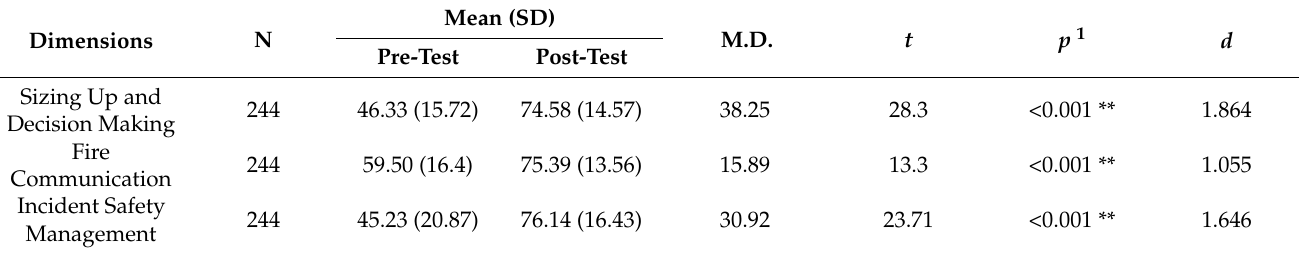
Table 3. T Test Analysis of the Pre- and Post-Test